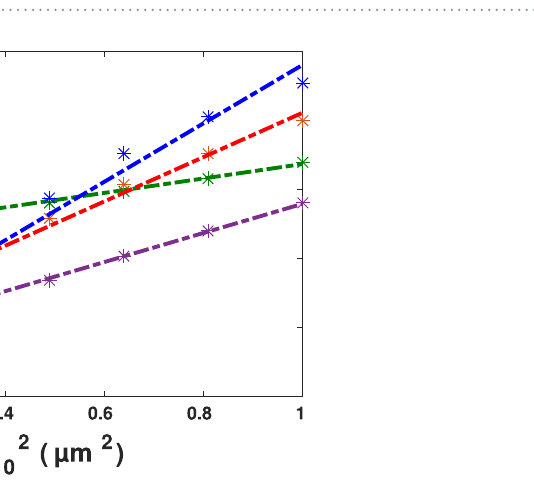
Figure 17. Experimental results for FCS calculated from smoothed FCS curves with σ = 3 μ s (circles) together with results for mimicked spot variation FCS (with spot size varying from r 0 to 0.4 r 0 from right to left) for the diffusion of AlexaFluor647-labeled streptavidin in a living cell in different preparations fitted to the standard formula.